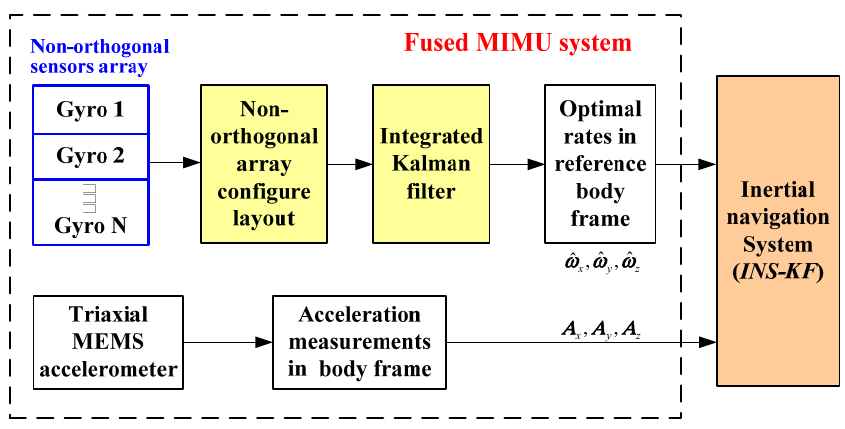
Figure 2. Structure of a redundant fused MIMU system.